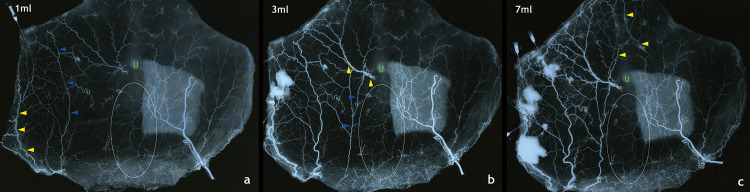
Serial venogram through the upper lateral venous stump after pre-injection of lead oxide into the arterial system.(a) The venogram taken after 1 mL injection of barium shows the vena comitantes of the superficial circumflex iliac artery (yellow arrowhead) and the superficial inferior epigastric artery (blue arrowhead). (b) The venogram taken after 3 mL injection of barium shows the medial main superficial inferior epigastric vein (blue arrowhead) and the vena comitantes of the periumbilical major perforator (yellow arrowhead). (c) The venogram taken after 7 mL injection of barium shows midline crossover in the supraumbilical area (yellow arrowhead). Note that there is no visible change in the infraumbilical midline area (white ellipse).